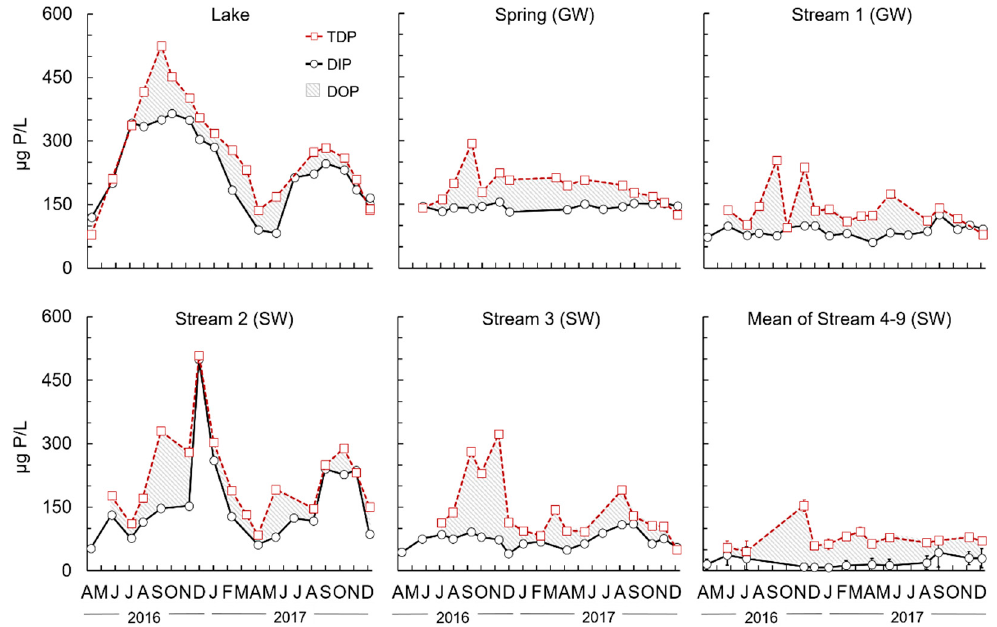
Figure 4. Concentrations of total dissolved phosphorus (TDP), dissolved inorganic phosphorus (DIP), and dissolved organic phosphorus (DOP) in the lake, spring and streams 1–9 at Nørresø during 2016–2017. Lower left panel shows the mean of streams 4–9 the error bars shows the standard deviation. Spring and stream 1 represent groundwater (GW), and streams 2–9 represent surface water (SW).